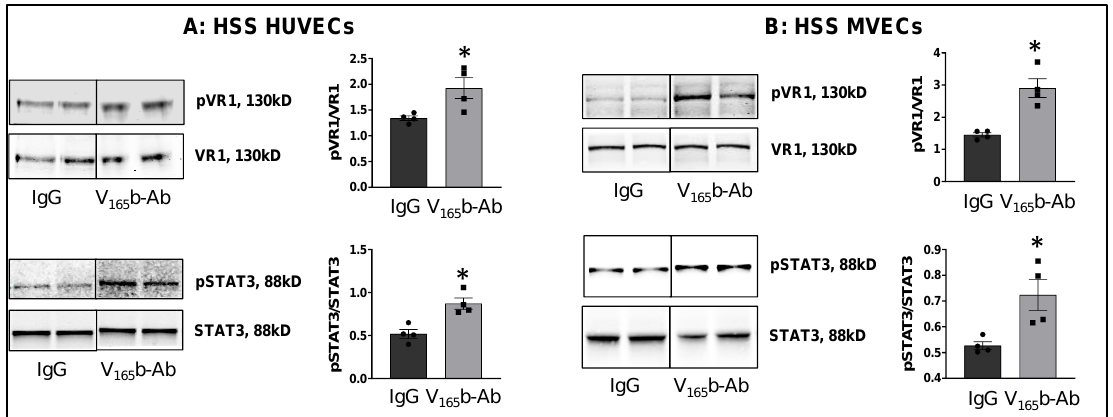
Figure 3. VEGF 165 b inhibition VEGFR1 activation in vitro and in vivo. Immunoblot analysis of pVR1(Y1333)/VR1 and pSTAT3/STAT3 in ( A ) HSS-HUVECs treated with IgG or VEGF 165 b-Ab for 24 h. n = 4. Unpaired t -test. ( B ) HSS-MVECs treated with IgG or VEGF 165 b-Ab for 24 h. n = 4. Unpaired t -test. * p < 0.05 considered significant. Data Mean ± SEM.